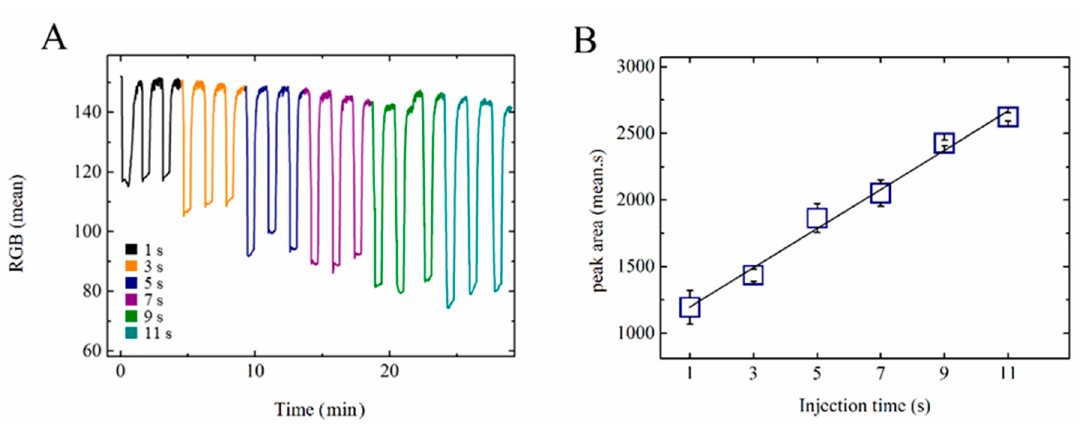
Figure 4. ( A ) RGB detection (camera + ImageJ software) of methylene blue dye, 0.2 g L − 1 , in NaH 2 PO 4 , 0.5 mol L − 1 , pH 4.3, 15 V, using different injection times. Reading and cleaning times of 20 and 60 s, respectively. ( B ) Illustration of the correlation between the injection time and RGB mean.